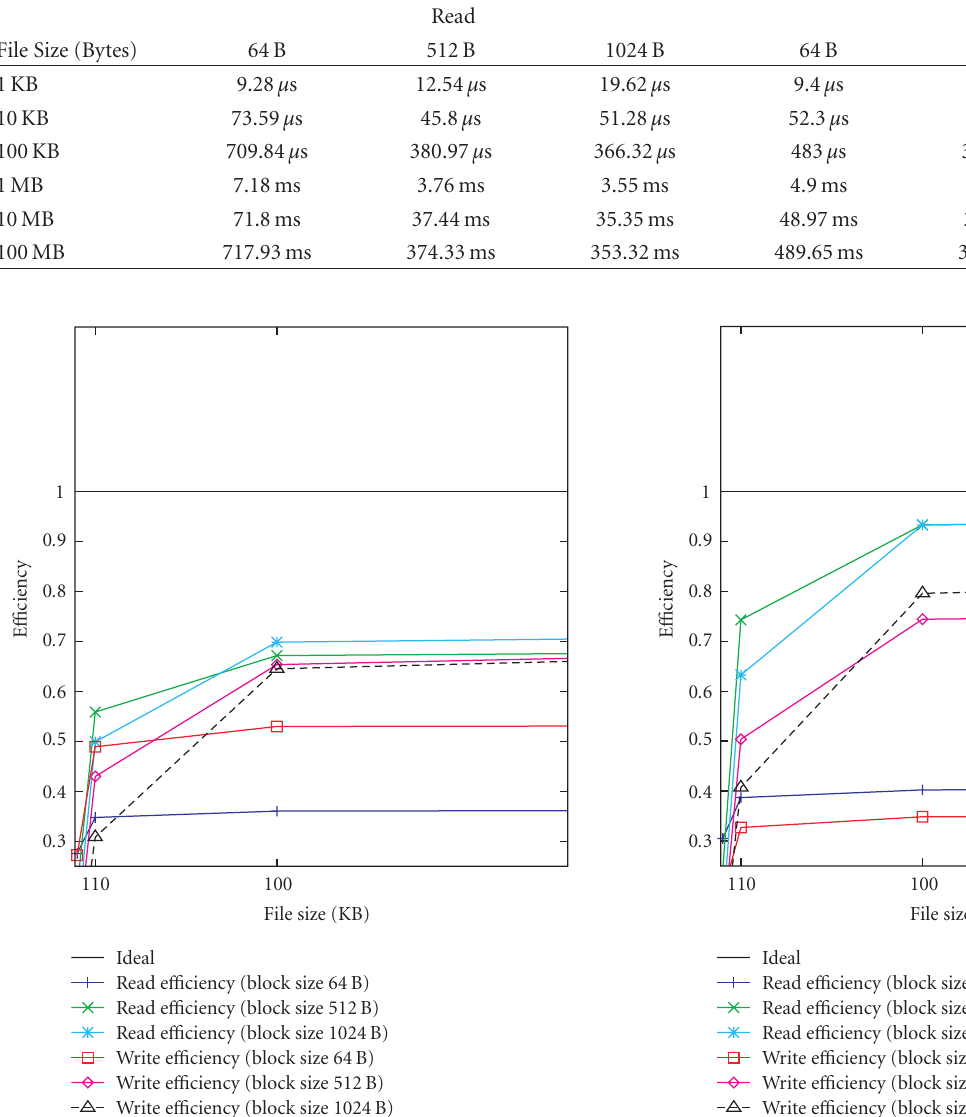
Figure 15: HWFS sequential read/write e ffi ciency with two RAM disks plotted against di ff erent file